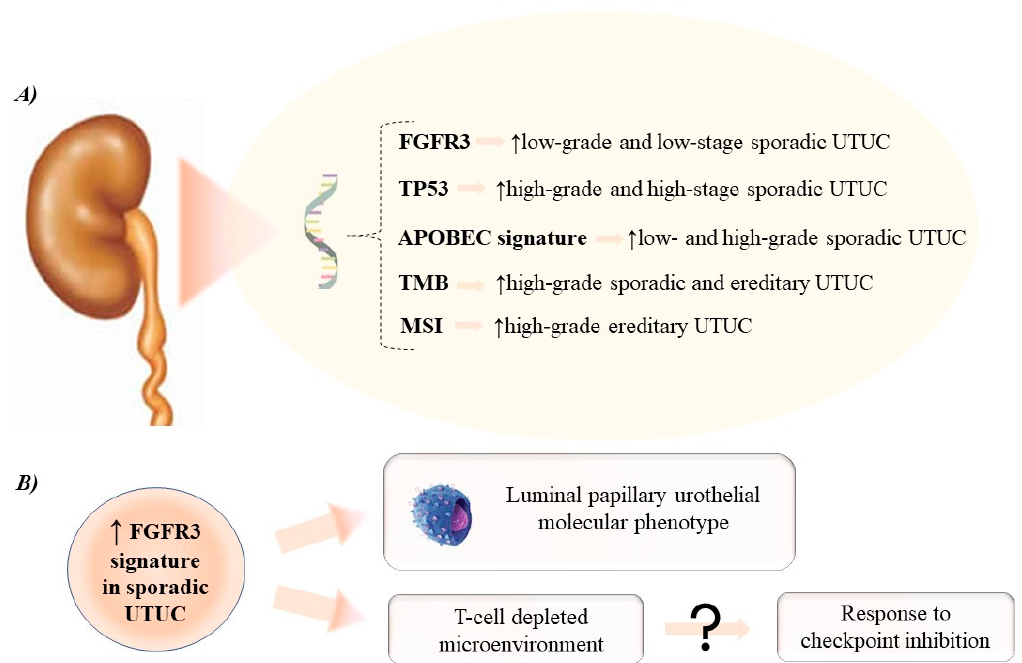
Figure 1. Overview of mutational ( A ) and gene expression ( B ) profile in upper tract urothelial carcinoma. APOBEC: apolilpoprotein B mRNA editing enzyme catalytic polypeptide-like; FGFR3: fibroblast growth factor receptor 3; MSI: microsatellite instability; TMB: tumor mutational burden; TP53: tumor protein 53; UTUC: upper tract urothelial carcinoma.